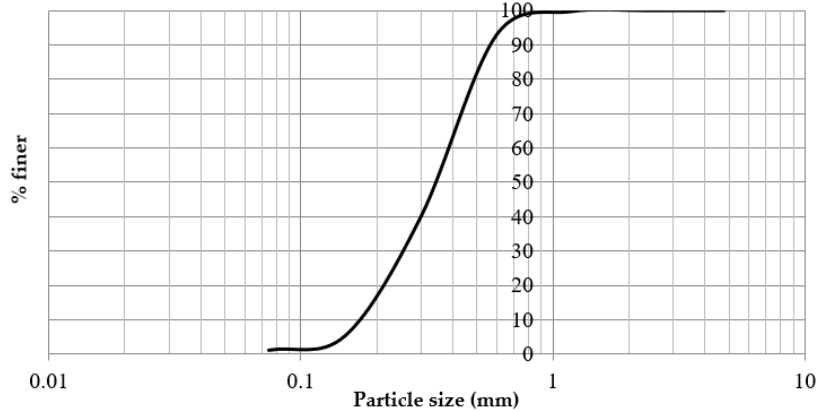
Figure 3. Particle size distribution curve of the soil employed for testing.